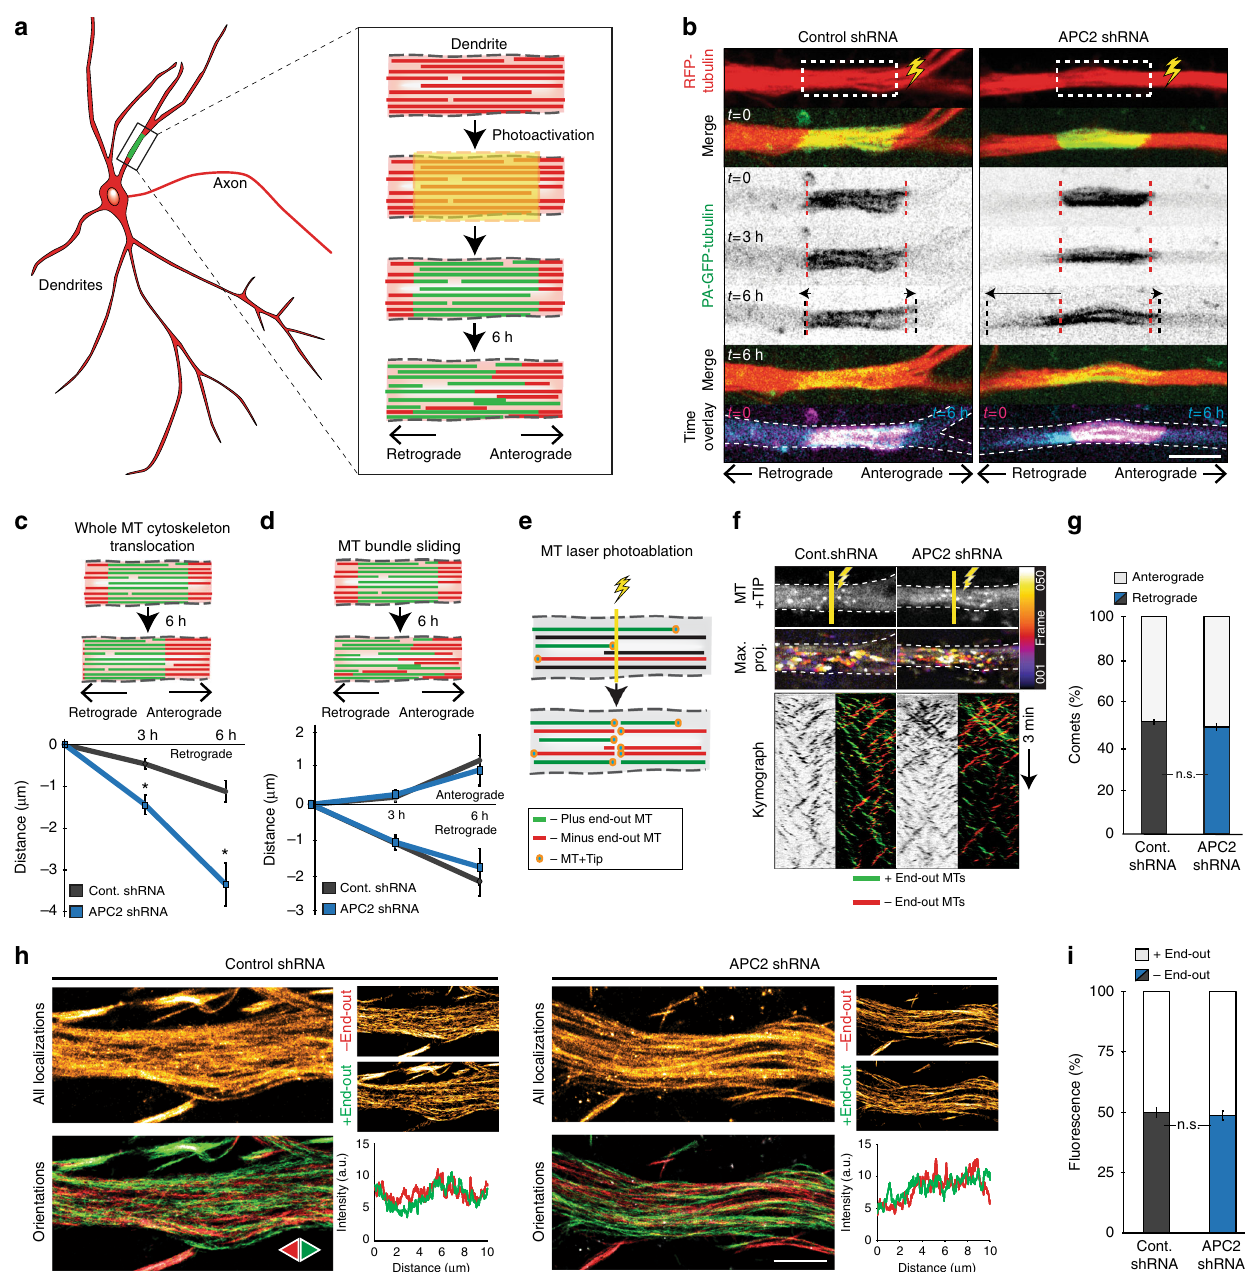
Fig. 4 APC2 effect on global organization of microtubule polarity in dendrites. a Neurons transfected with RFP-tubulin, PA-GFP-tubulin and either control or APC2 shRNA on DIV11 – 12 were live imaged on DIV15 – 16 (schematic drawn by O.I.K.). b Representative images of control or APC2 depleted neuron with photoactivated region of dendrite undergoing microtubule bundle sliding. Red dotted line represents edges of photoactivated region at t = 0. Black dotted line represents edges photoactivated region at the corresponding time point. Time overlay has frame at t = 0 in magenta merged with t = 6h in cyan. c Translocation distance of whole photoactivated region towards the cell body was measured ( n = 21 dendrites control shRNA, n = 26 dendrites APC2 shRNA, N = 3, Two-Way ANOVA, Tukey post-hoc). d Distance of microtubule bundles sliding out of the photoactivated region both towards and away from cell body was measured ( n = 8 dendrites control shRNA, n = 14 dendrites APC2 shRNA, N = 3, Two-Way ANOVA, Tukey post-hoc). e Schematic representation of microtubule photo-ablation in dendrites. f Neurons were transfected with GFP-MT + TIP and either control or APC2 shRNA at DIV11 – 12 and imaged DIV15 – 16. Proximal dendrites were photo-ablated 30 µ m away from cell body and microtubule orientations were imaged for 3min. Representative images of GFP-MT + TIP still frames, color-coded maximum projections and kymographs coded for direction of comets are shown. g Percentage + TIP comets in dendrites toward cell body post photo-ablation. ( n = 14 dendrites control shRNA, n = 17 dendrites APC2 shRNA, p = 0.199, N = 2, Independent samples t -test). h Microtubule motor based super-resolution reconstruction of segments of proximal dendrites of neurons at DIV15 transfected with RFP-tubulin and either control or APC2 shRNA. Signal shown is derived from motor-PAINT. Red microtubules are minus-end-out, green are plus-end-out. Line scans are of green and red signals corresponding to microtubule orientations along 10 µ m segments of dendrites. i Percentage mean red intensity to total was quanti fi ed as a measure of percentage minus-end-distal microtubules in the control or APC2 depleted neurons ( n = 5 dendrites control shRNA, n = 7 dendrites APC2 shRNA, p = 0.588, N = 2, Independent samples t -test). Graphs represent mean±SEM. * p ≤ 0.05. Scale bars represent 5 μ m in b and 2 μ m in